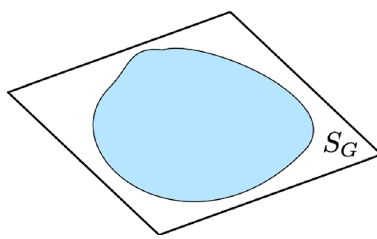
, represented by a light H